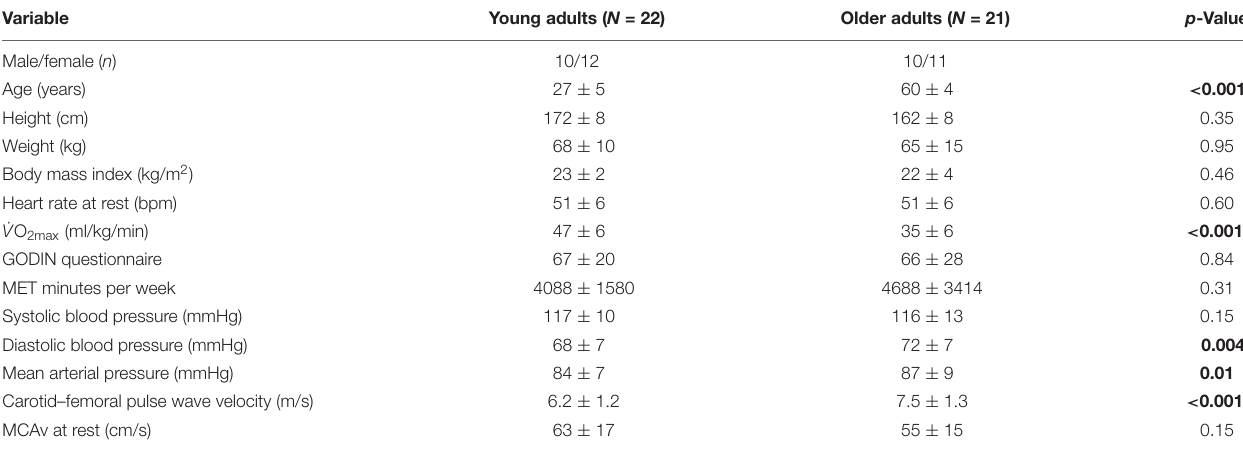
TABLE 1 | Characteristics of participants.